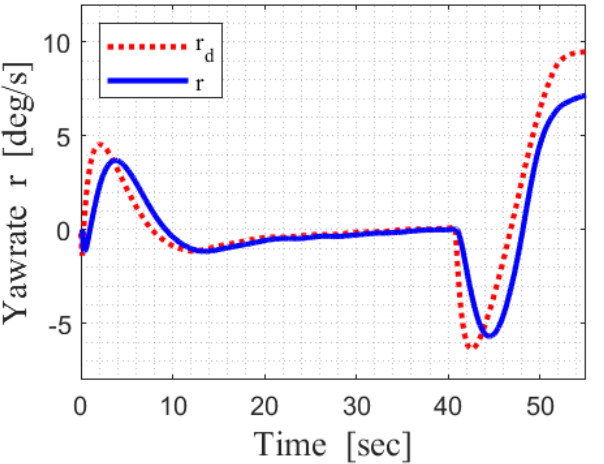
Figure 16. Yaw-rate tracking of the USV when MRAC was used in the parallel-type berthing